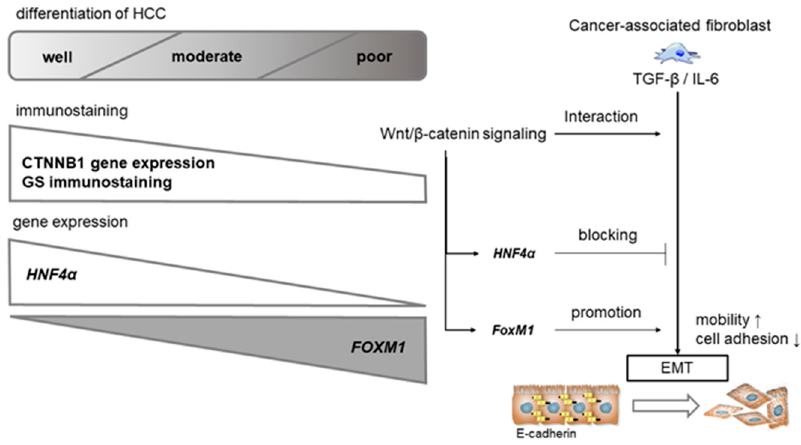
Figure 1. Wnt/ β -catenin canonical pathway interacting with EMT and the TGF- β /IL-6 axis. It is well known that the TGF- β /IL-6 axis regulates EMT, and Wnt/ β -catenin has been reported to directly promote EMT. Wnt/ β -catenin activation mutations are present in approximately 40% of HCCs, especially in well-to-moderately differentiated HCCs. HNF4 α , a target gene of Wnt, suppresses EMT, resulting in a non-aggressive phenotype with less metastasis and invasion. FOXM1, which is regulated by Wnt, promotes EMT and decreases E-cadherin expression, resulting in a poor prognostic phenotype with aggressive metastasis and invasion.